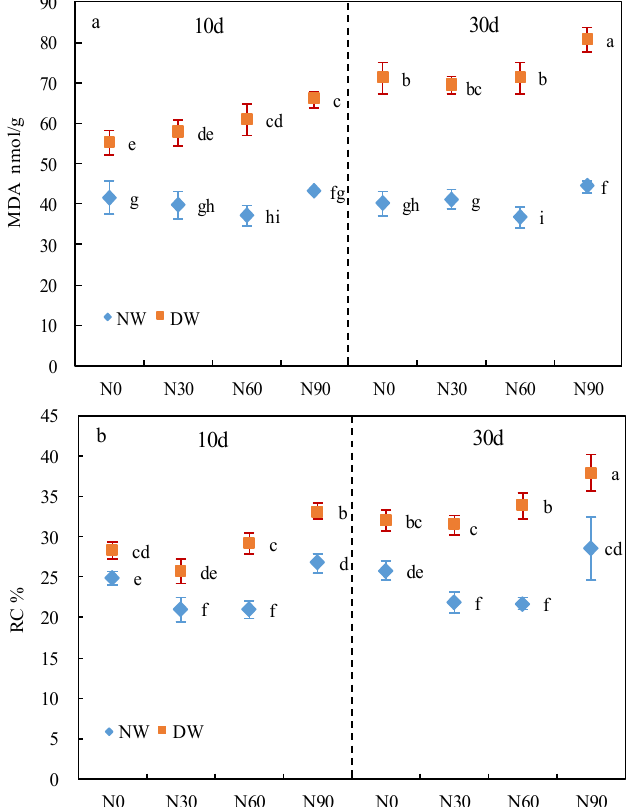
Figure 1. ( a ) Effect of drought stress and nitrogen deposition on MDA content; ( b ) effect of drought stress and nitrogen deposition on RC. Water supply treatments: normal water supply (NW) or drought stress (DW) for 10 d or 30 d. Nitrogen deposition treatments: control (N0, 0 kg · hm − 2 year − 1 ), low nitrogen deposition (N30, 30 kg · hm − 2 year − 1 ), medium nitrogen deposition (N60, 60 kg · hm − 2 year − 1 ), or high nitrogen deposition (N90, 90 kg · hm − 2 year − 1 ). Abbreviations: MDA, malondialdehyde; RC, relative conductivity. Data points represent means ± the SD; n = 5. Data points with the same lowercase letter are significantly different ( p < 0.05) according to Tukey’s test.